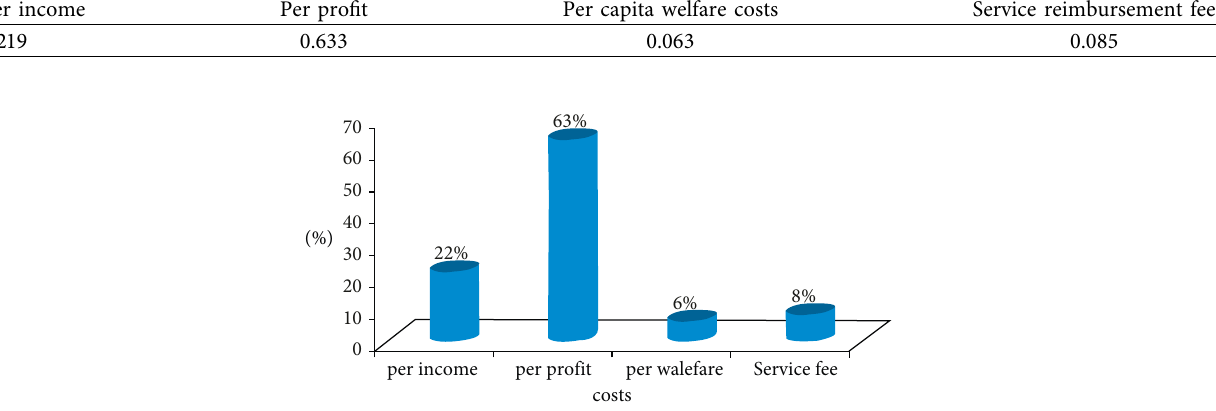
Figure 2: Weight of criteria from financial